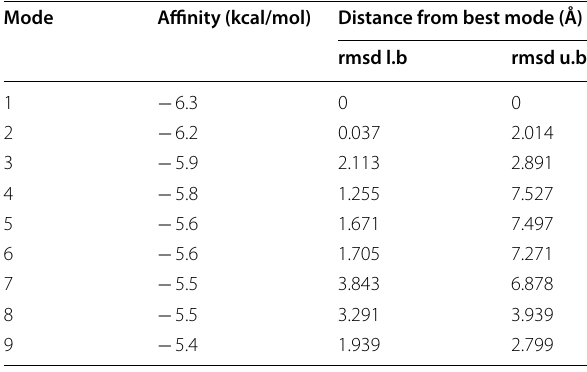
rmsd, Root-mean-square deviation; l.b, Lower bound; and u.b, Upper bound